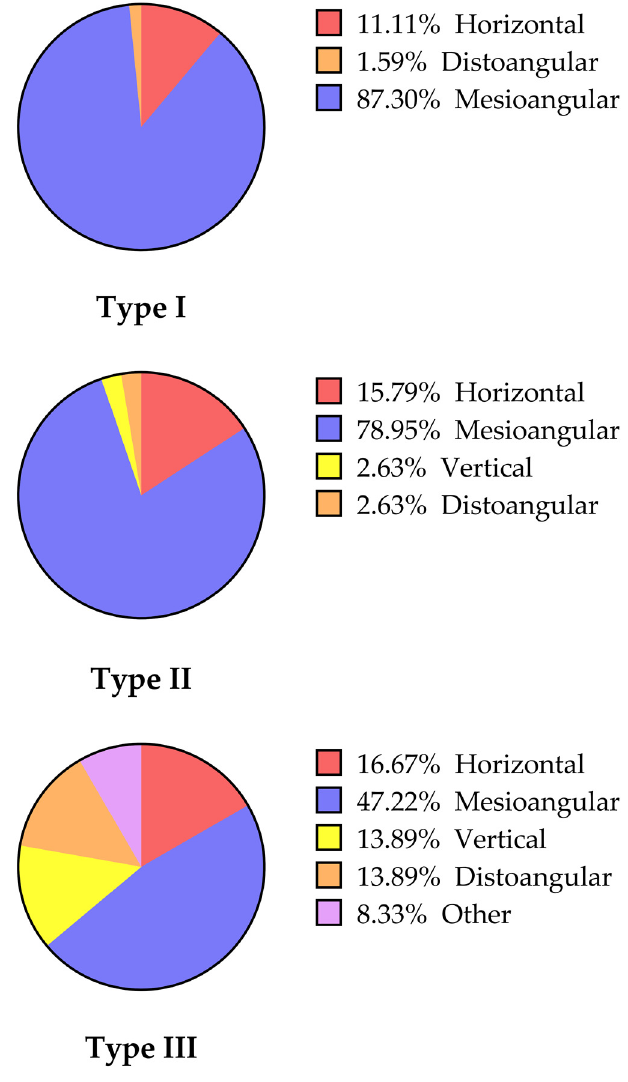
Figure 4. Impaction types of the 137 impacted MM2. The results of the binary regression analysis of cysts around the impacted MM2 with other variables are presented in Table 4. Specifically, in the relationship between the impaction depth of MM2 and the concurrent occurrence of cysts, MM2 covered by bone were more likely to be accompanied by cysts than MM2 covered by mucosa (odds ratio [OR], 51.92; p < 0.001). Moreover, MM2 development was significantly associated with the occurrence of cysts: compared with patients with Stage 11 development, those with Stages 8, 9, and 10 were 229.97, 113.47, and 42.30 times more likely to have cysts (OR, 229.97; p < 0.01, OR, 113.47; p < 0.05, and OR, 42.30; p < 0.05, respectively) (Table